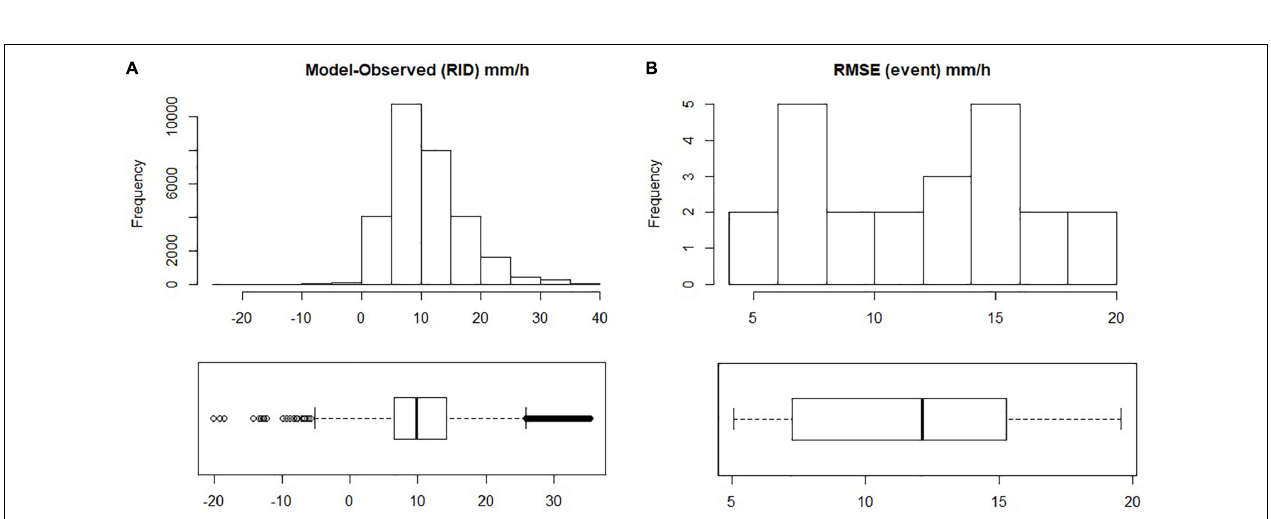
FIGURE 7 | (A) Histogram and boxplot of the differences between the maximum modeled rainfall and observed rainfall using 29,353 RID data. The positive values represent an overestimation (correct model). The negative data represent an underestimation (incorrect model) by 0.4%. (B) Histogram and boxplot of RMSE for the corresponding 23 rainfall